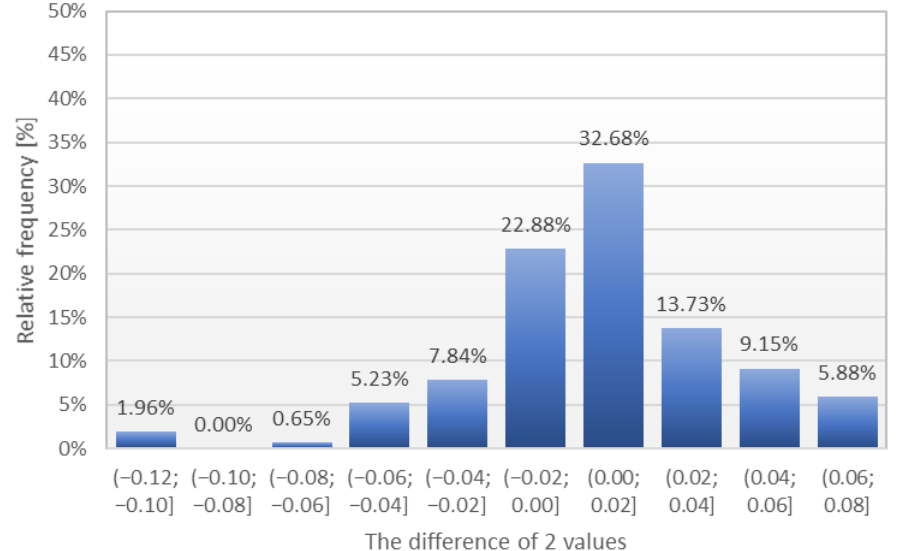
Figure 20. Distribution plot of differences between measurement by methods (left side of arch support frame).